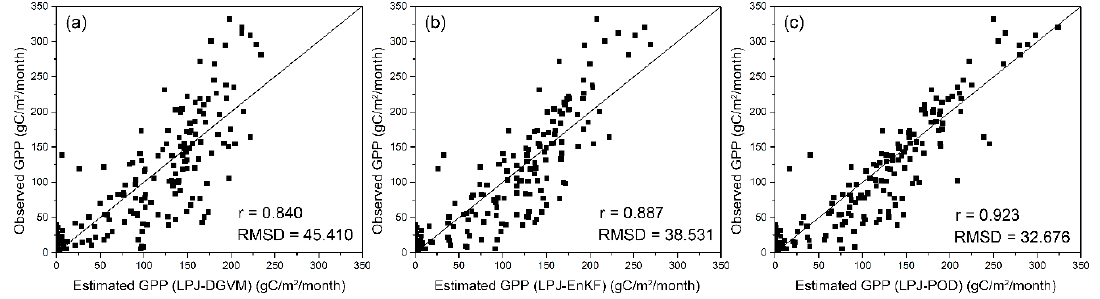
Figure 6. ( a – c ) Scatterplot of observed versus estimated monthly gross primary productivity (GPP) at the six sites listed in Table 1.